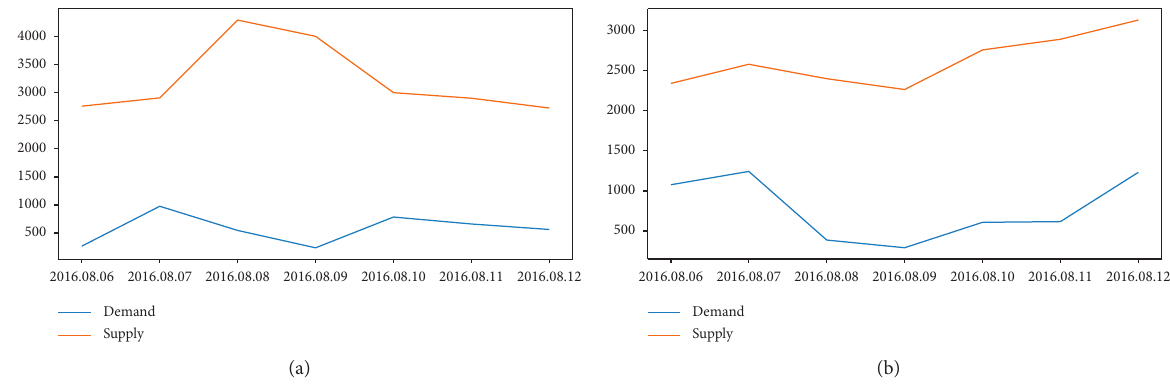
Figure 7: The supply and demand relationship around hotspots. The blue line is the demand for taxis, and the orange line is the supply. (a) Beijing railway station. (b) Beijing south railway